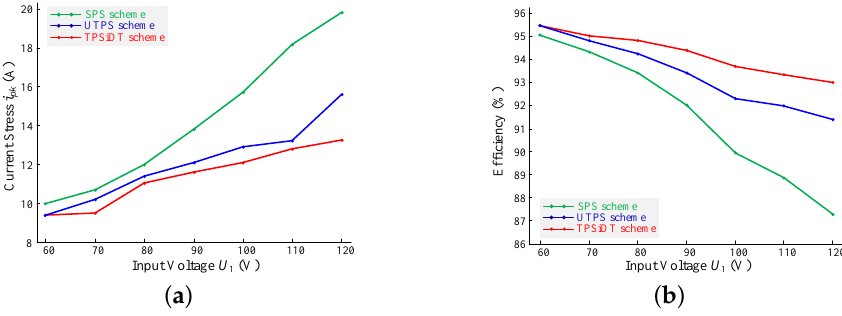
Figure 24. Experimental curves versus the input voltage U 1 with M min = 0.1: ( a ) current stress; and ( b )